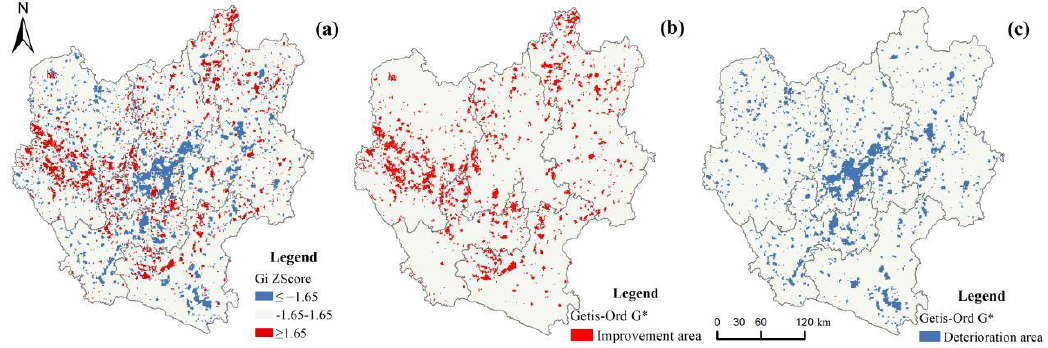
Figure 6. ( a ) Hot and cold spots areas of change in ecosystem health levels from 1990 − 2020. ( b ) Ecosystem health improvement areas. ( c ) Ecosystem health deterioration areas.